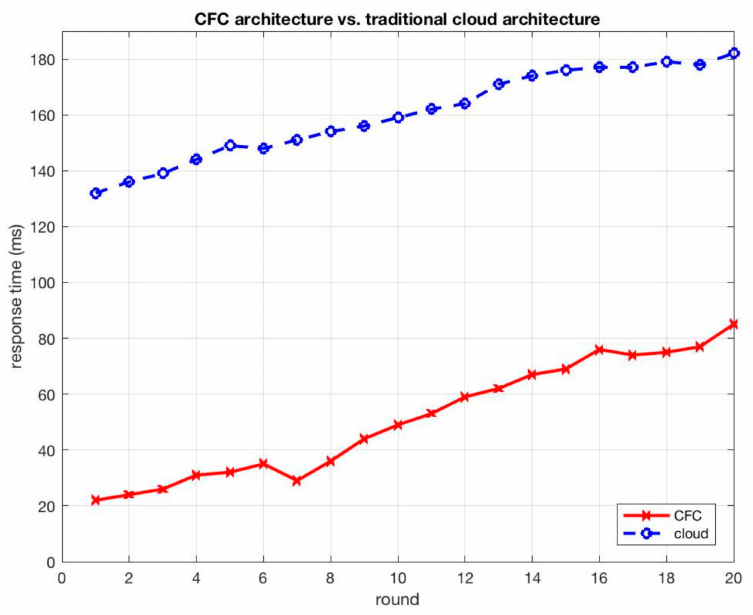
Figure 11. The response time of query the newest data (the proposed architecture vs. traditional cloud).